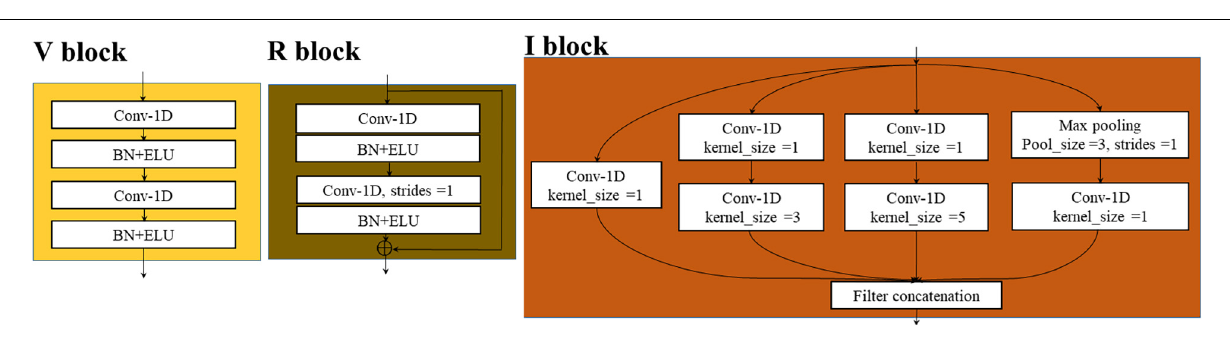
FIGURE 2 | The inner structures of three typical